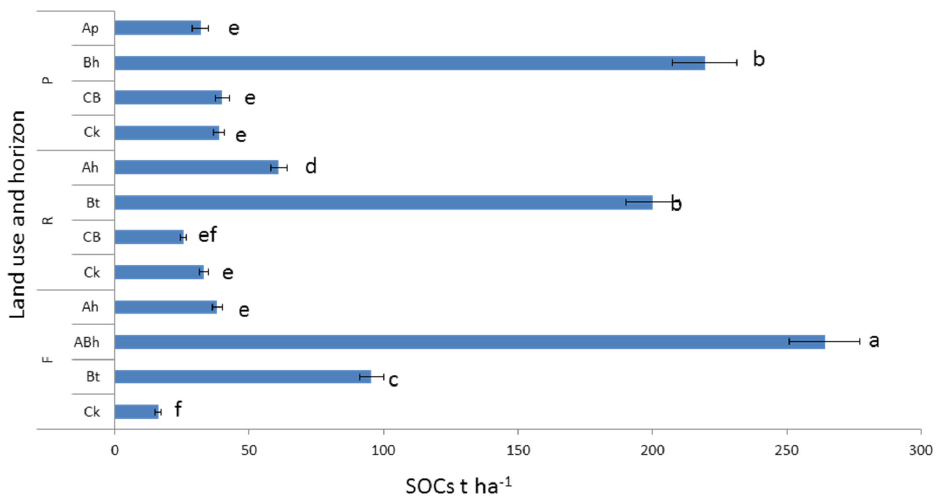
Figure 4. Soil organic carbon stock according to the land use (forest, F; reforestation, R; prairie, P) per soil depth interaction. Data followed by the same letter are not statistically different from each other (Student’s test, p = 0.05).